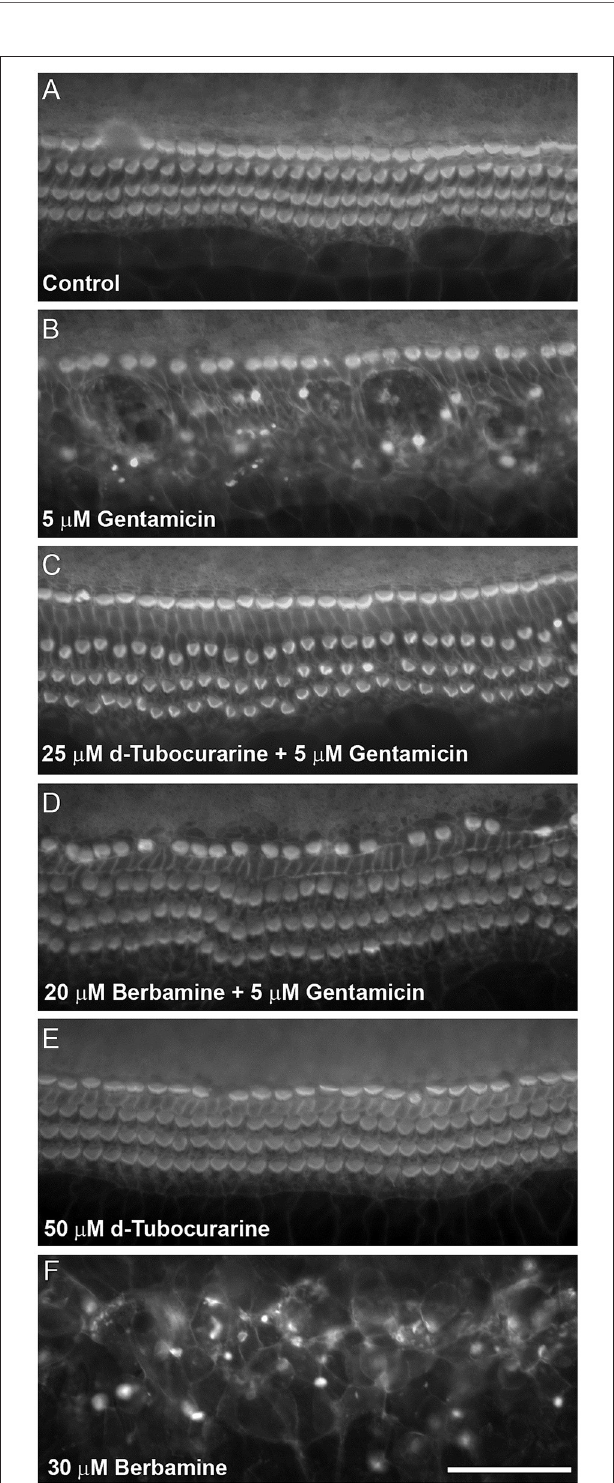
FIGURE 3 | d-Tubocurarine and berbamine protect cochlear OHCs from gentamicin damage. Protection assay using cultures prepared from CD-1 mice at postnatal day 2 (P2). Cultures were stained with TRITC-phalloidin at the end of the experiment allowing visualization of the actin-rich stereocilia. (A) Control culture incubated for 48 h in the presence of medium alone. The sensory hair